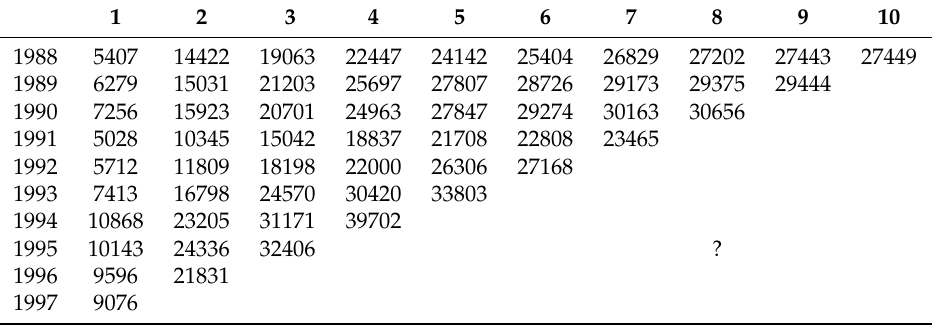
Table 2. Cumulative paid loss triangle observed in the past (commercial auto data set, group code 2712).